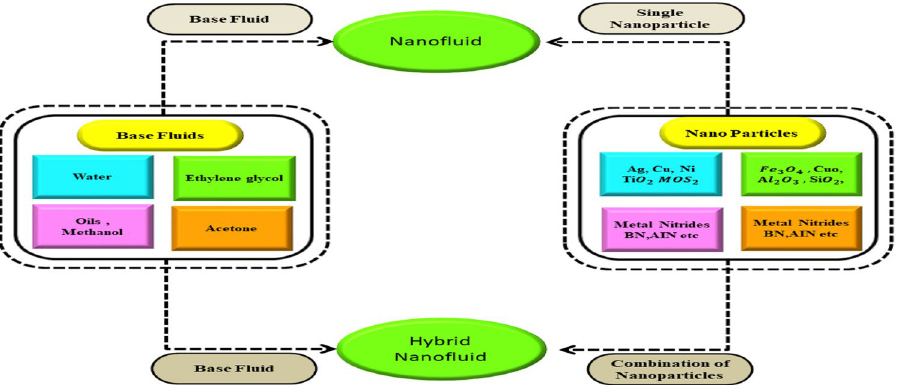
Figure 1. Hybrid nanofluid and nanofluid manufacturing